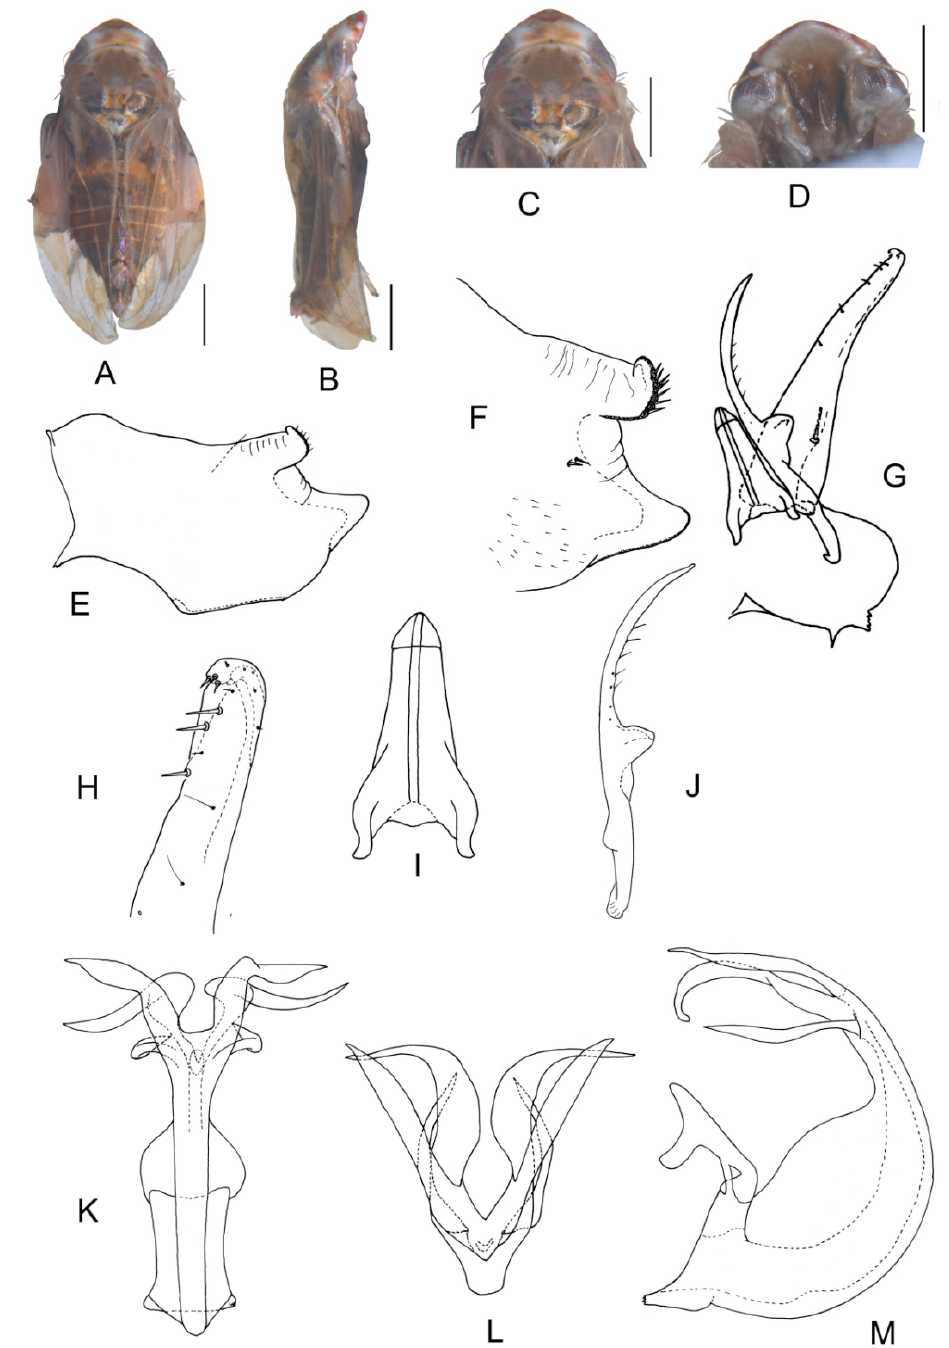
Figure 14. Eurhadina ( Singhardina ) extensa sp. nov. : ( A ) habitus, dorsal view; ( B ) habitus, lateral view; ( C ) head and thorax, dorsal view; ( D ) face; ( E ) male pygofer side, lateral view; ( F ) hind part of pygofer, lateral view; ( G ) subgenital plate, connective, paramere and sternite IX, dorsal view; ( H ) apex of subgenital plate, dorsal view; ( I ) connective, dorsal view; ( J ) paramere, dorsal view; ( K ) aedeagus, posterior view; ( L ) apex of aedeagal shaft, dorsal view; and ( M ) aedeagus, lateral view. Scale bars: 0.5 mm.